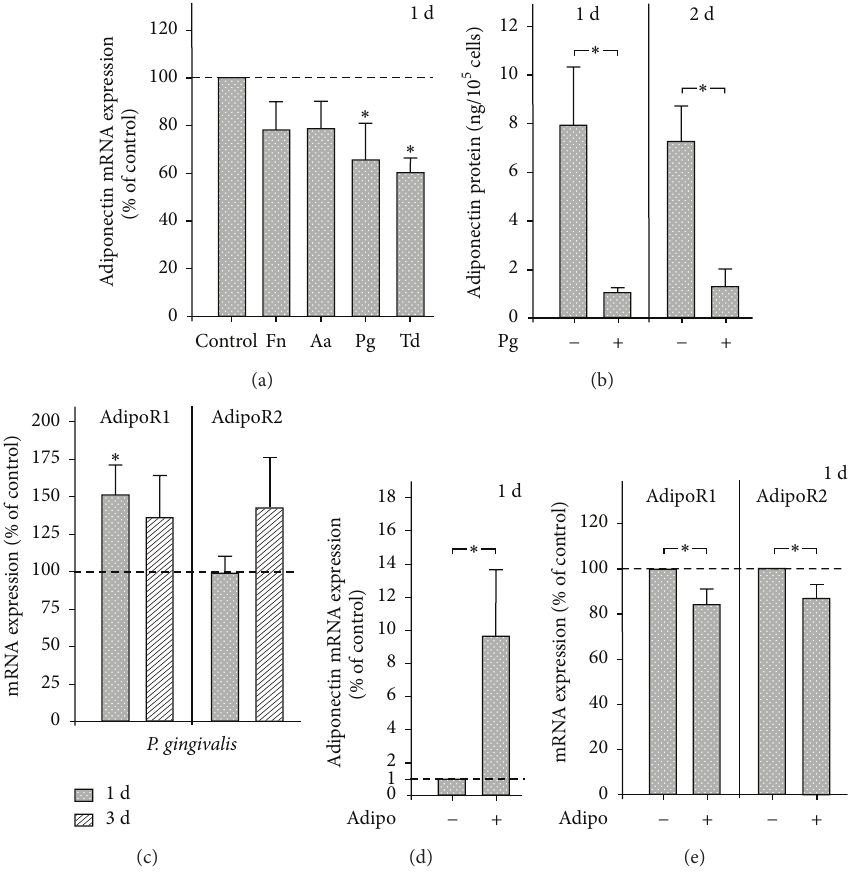
Figure 3: Effects of F. nucleatum ( Fn ), A. actinomycetemcomitans ( Aa ), P. gingivalis ( Pg ), and T. denticola ( Td ) (all OD: 0.1) on the mRNA expression of adiponectin in PDL cells at 1 d (a). Untreated cells were used as control. Mean ± SEM ( 𝑛 = 9 ); ∗ significantly ( 𝑃 < 0.05 ) different from control. Effect of P. gingivalis ( Pg ; OD: 0.1) on the adiponectin protein level in medium from PDL cells at 1d and 2 d (b). Untreated cells were used as control. Mean ± SEM ( 𝑛 = 9 ); ∗ significant ( 𝑃 < 0.05 ) difference between groups. Effects of P. gingivalis (OD: 0.1) on the mRNA expression of adiponectin receptors (AdipoR1 and AdipoR2) at 1d and 3 d (c). Untreated cells were used as control. Mean ± SEM ( 𝑛 = 15 ); ∗ significantly ( 𝑃 < 0.05 ) different from control. Effects of adiponectin (1 𝜇 g/mL) on its own mRNA expression (d) and the expression of its receptors AdipoR1 and AdipoR2 (e) at 1d. Untreated cells served as control. Mean ± SEM ( 𝑛 = 18 ); ∗ significant ( 𝑃 < 0.05 ) difference between